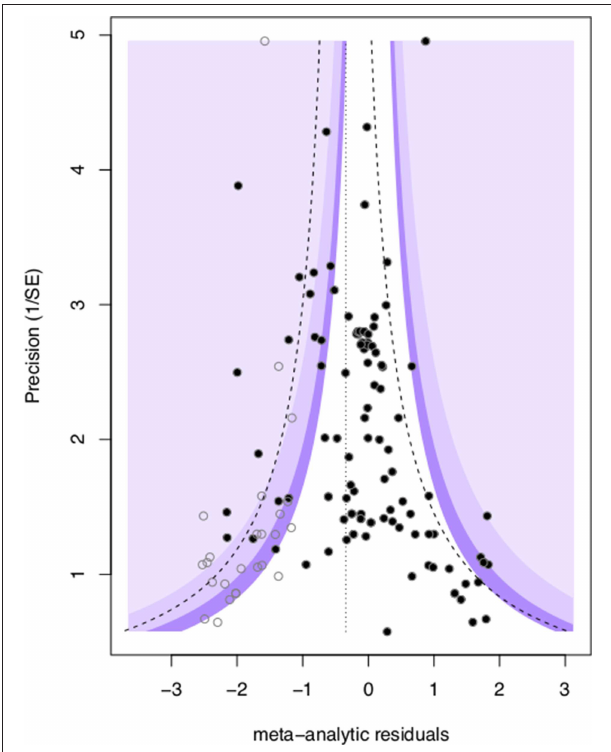
FIGURE 4 | Visualization of publication bias via a contour funnel plot showing meta-analytic residual ln (cid:0) OR (cid:1) vs. corresponding precision (1 / SE ln ( OR ) , black circles). The plot also illustrates the trim and fill “missing” data points (open circles) required to restore funnel symmetry. The dotted line represents the ln (cid:0) OR (cid:1) adjustment which was applied to the mean of the meta-analytic residuals to correct for publication